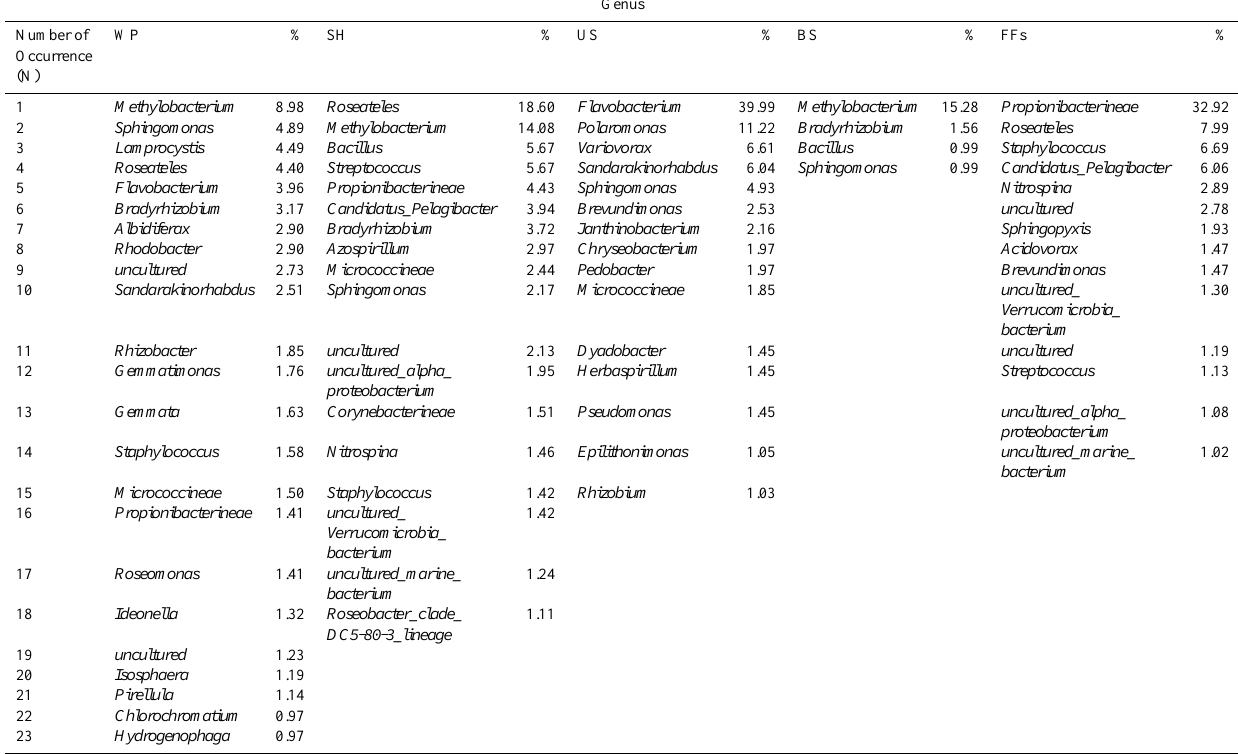
Table A2. Genus distribution (>1%) of Bacterial community in Arctic samples/urban snow by NGS. Windpack snow (WP), surface hoar snow (SH), urban snow (US), blowing snow (BS), and frost flowers